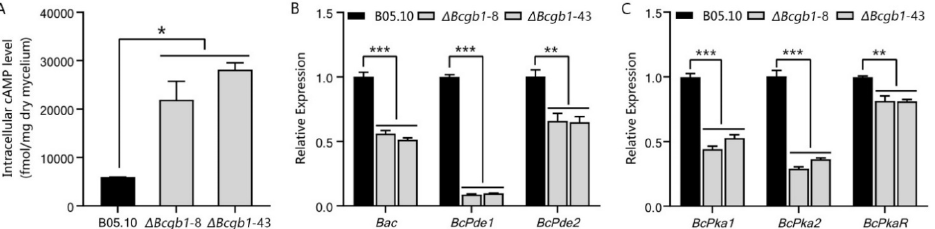
Figure 5. Bcgb1 is involved in the regulation of intracellular cAMP levels. ( A ) Quantitative determination of intracellular cAMP levels in mycelia of the indicated strains cultured in PDB for 2 days. Two biological repetitions with three replicates were assayed. The error bars represent the SD of three replicates. ( B ) Transcript level of Bac , BcPde1 , and BcPde2 in the WT and the Δ Bcgb1 mutants of B. cinerea . ( C ) Transcript level of BcPka1 , BcPka2 , and BcPkaR in the WT and the Δ Bcgb1 mutants of B. cinerea . * p < 0.05, ** p < 0.01, *** p < 0.001.